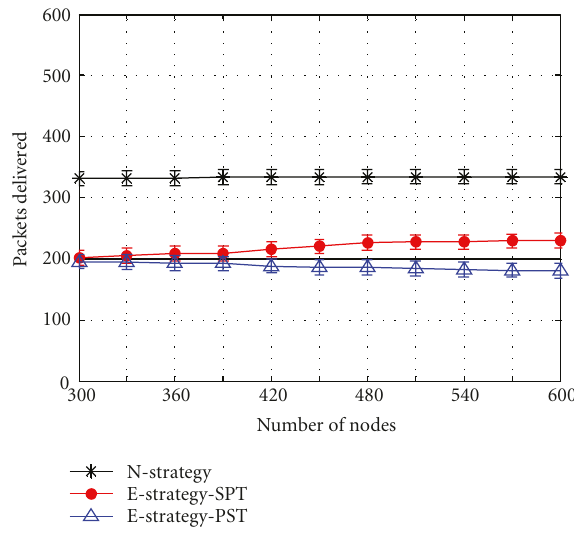
Figure 4: Cost versus node